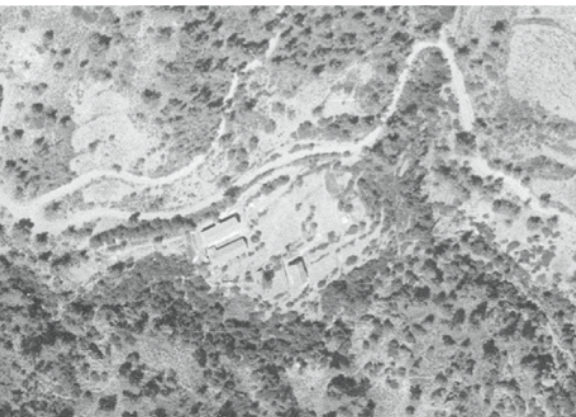
Figure 2. Panagia tou Araka, Lagoudhera. 1963, historical aerial picture, Department of Land and Survey of Cyprus.